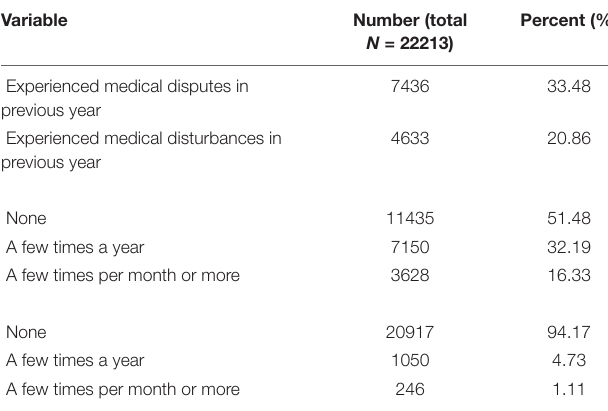
TABLE 4 | Frequency of medical disputes, medical disturbances, verbal and physical violence among Chinese physicians.